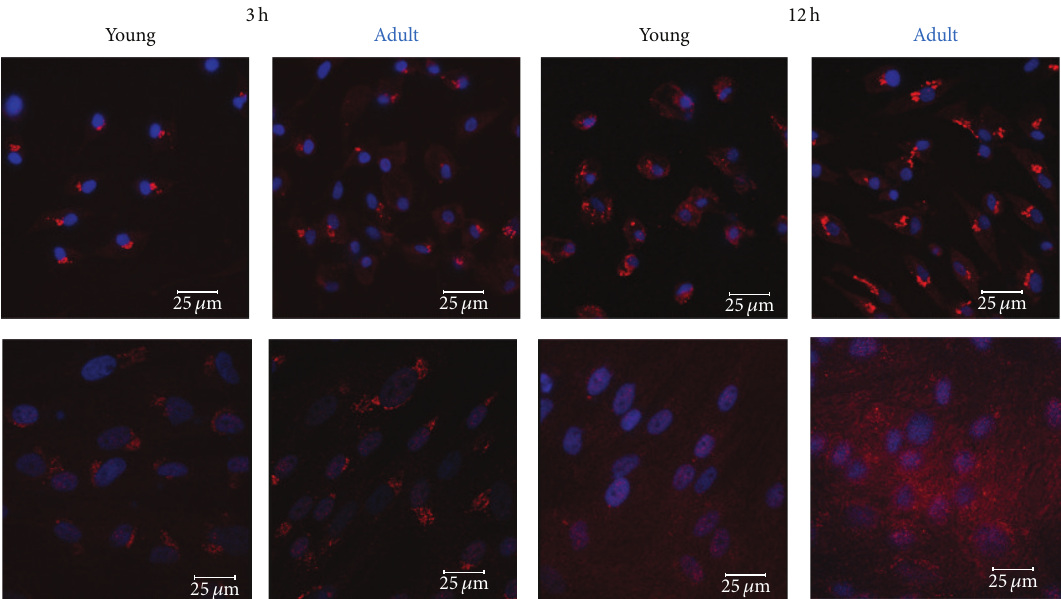
Figure 10: Expression of nestin in undifferentiated and differentiated low passaged eBM-MSCs. Confocal microscopy shows the expression of nestin (red) in neural crest-like cells (upper panels) and in undifferentiated controls (lower panels) from eBM-MSCs of young and middle- aged horses after 3 h and 12 h of chemical induction. DAPI was used to stain the nuclei (blue). Note the predominant perinuclear localization of nestin. Scale bar = 25 𝜇 m.